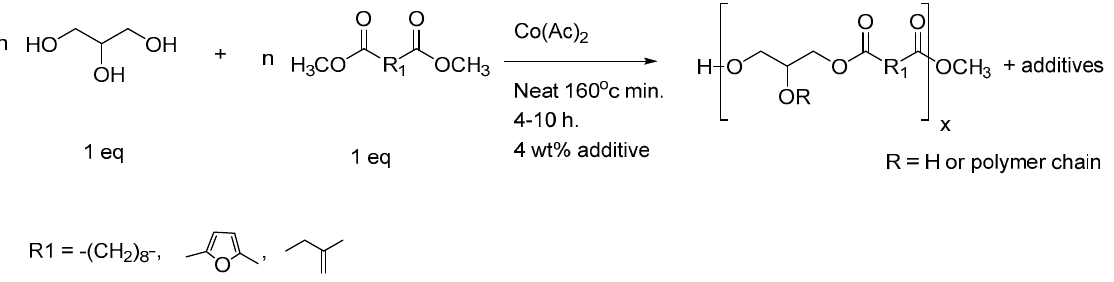
Figure 9. Alternative pathway to access to ester-functionalized prepolymers.